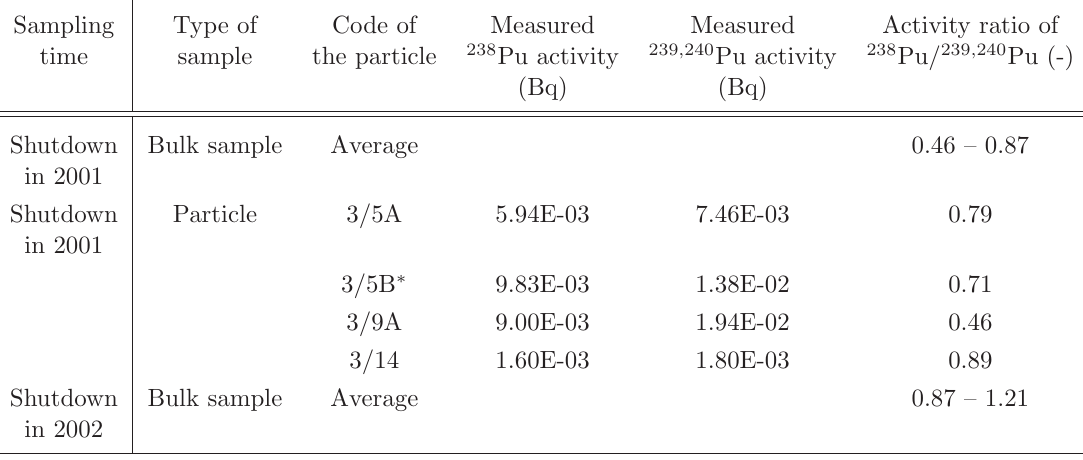
Table 1 Measured Pu activities of hot particles and bulk samples originating from failed fuel under normal operating conditions in Unit 3 of Paks NPP during two consecutive operation cycles (2001 and